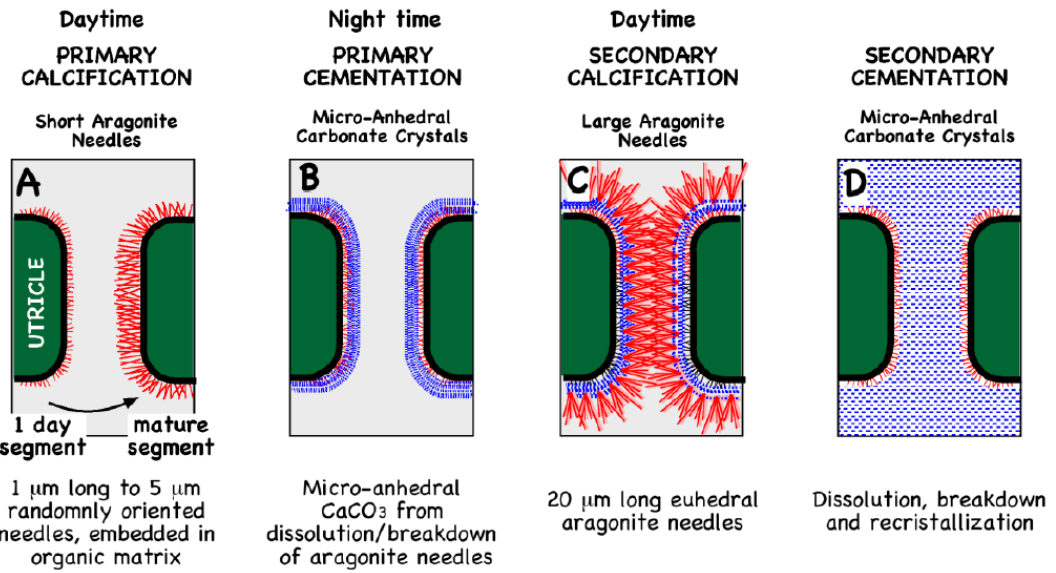
Figure 10. Calcification stages of Halimeda [78,79]. ( A ): Growth of short skeletal needles on the utricle wall; ( B ): recrystallization of short needles to micron-sized anhedral crystals. ( C ): secondary calcification by long, dense, euhedral, skeletal-aragonite needles, ( D ): the primary inter-utricular space in the rim of the segment is filled with micron-sized anhedral crystals. (This figure is an original interpretation by L. Pomar based on cited sources [78,79]).